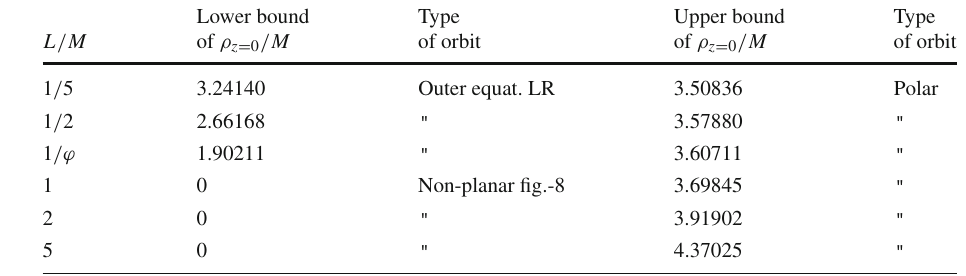
Table 1 The lower and upper bounds of ρ z = 0 , for the various values of L plotted in Fig. 7. Non-zero values are listed to an accuracy of six significant figures. The orbit